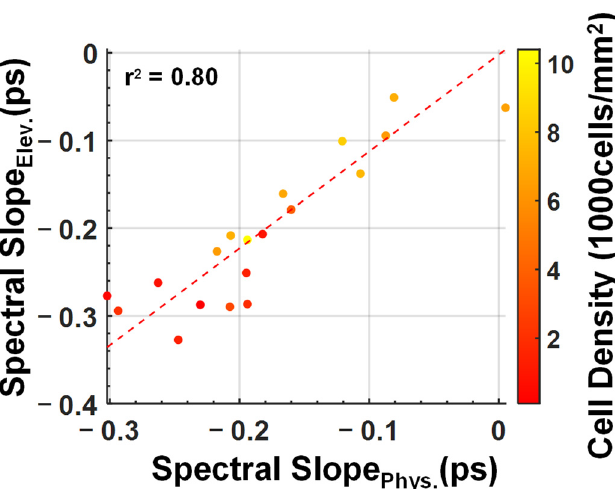
Figure 6. A scatter plot showing the relationship between endothelial cell density and the two spectral slope parameters, S Elev and S Phys in units of picoseconds (ps) The dashed line represents the line of best fit between the two variables. The r 2 value of 0.80 indicates that there is a strong linear relationship between the two spectral parameters.